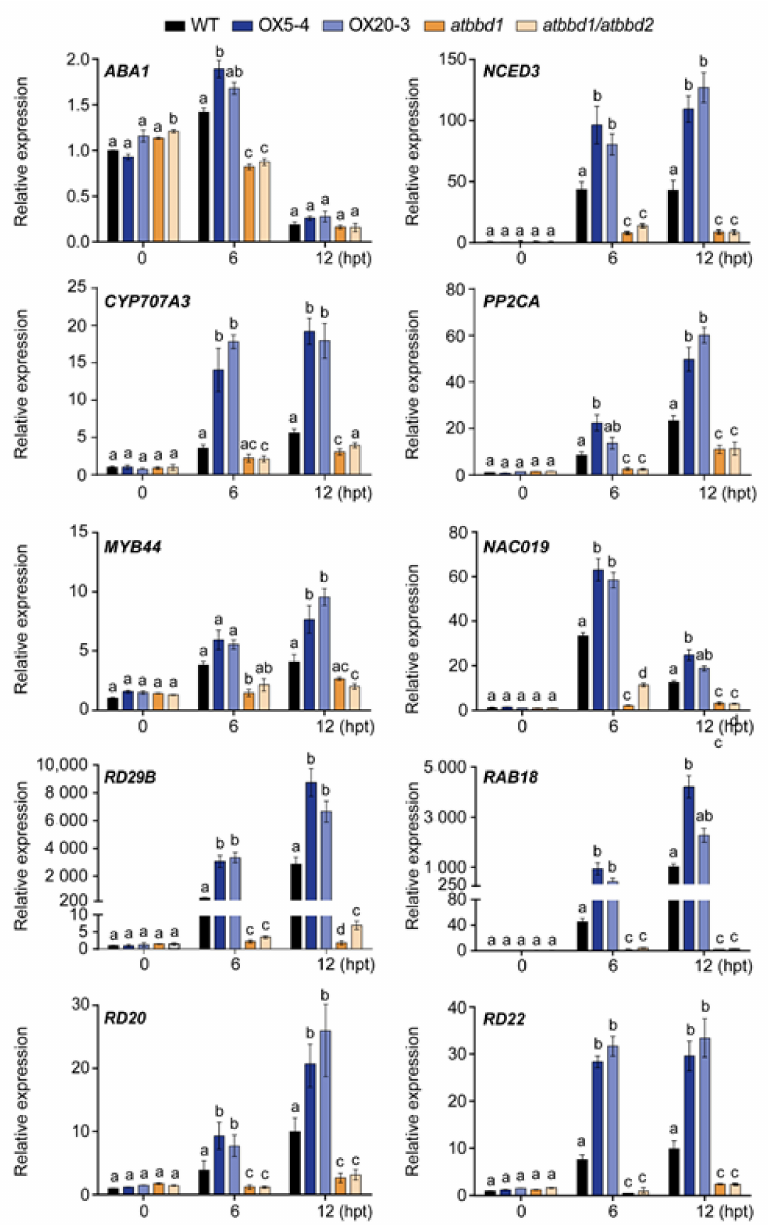
Figure 7. Expression of ABA-inducible and drought stress-inducible marker genes in the WT, OX5-4, OX20-3, atbbd1, and atbbd1/atbbd2 lines under drought stress conditions, as assayed by qRT- PCR. Three-week-old soil-grown plants were stressed by watering with 20% PEG 6000, and gene expression was analyzed at designated time points. Relative expression levels of ABA1 , NCED3 , CYP707A3 , PP2CA , MYB44 , NAC019 , RD29B , RAB18 , RD20, and RD22 in the WT, OX5-4, and atbbd1 plants. The relative gene expression was calculated and normalized to the reference gene eIF4a1. The normalized mRNA levels at 0 h were set to 1. Data represent the mean ± standard error values of three independent experiments. One-way ANOVA with post-hoc Tukey test was used for the statistical comparison of all genotypes. Different letters indicate significant differences among genotypes at each time point ( p <